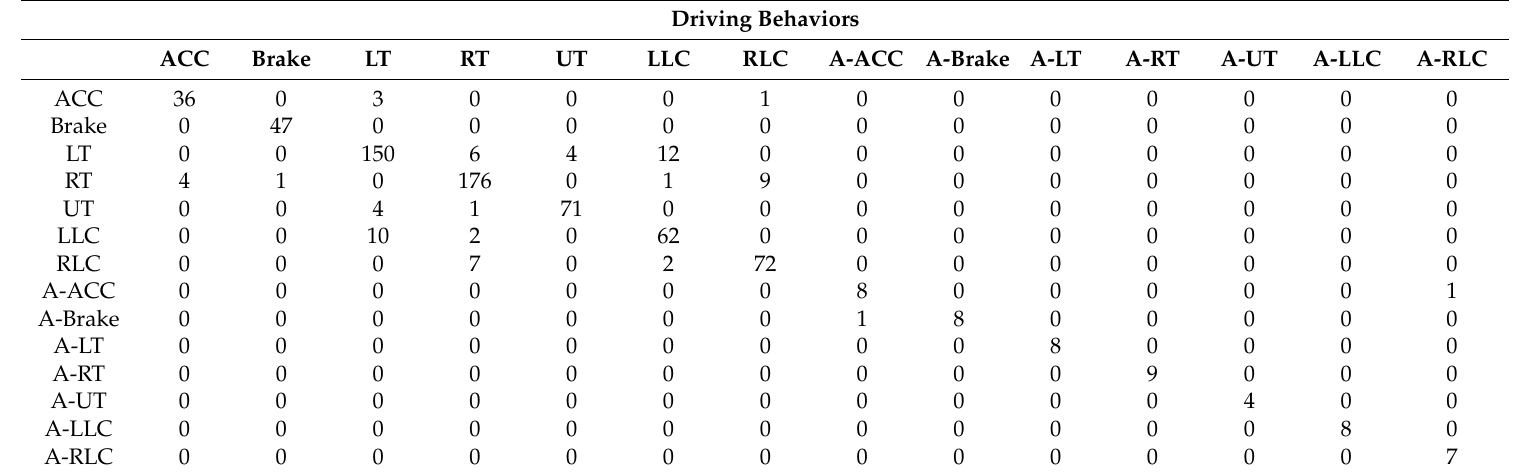
Table 8. The classification results of specific driving behaviors.